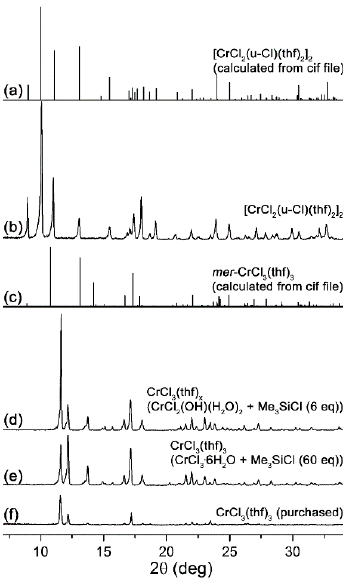
Figure 3. X-ray powder diffraction (XRD) patterns of [CrCl 2 (μ-Cl)(thf) 2 ] 2 calculated from cif file ( a ) and measured ( b ) and those of CrCl 3 (thf) 3 calculated from cif file ( c ), obtained from the reaction ‘CrCl 2 (OH)(H 2 O) 2 + Me 3 SiCl (6 eq)’ ( d ), obtained from the reaction ‘CrCl 3 ·6H 2 O + Me 3 SiCl (60 eq)’ ( e ), and purchased ( f ).